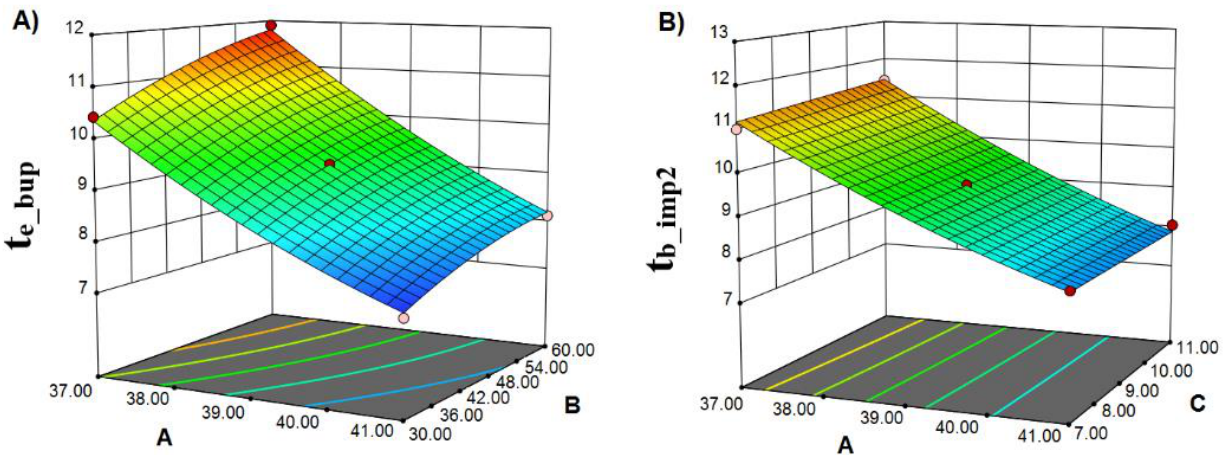
Figure 2. Three-dimensional graphs of ( A ) t e_bup = f (%ACN at the start of the gradient, salt concentration — mM) and ( B ) t b_imp2 = f (%ACN at the start of the gradient, gradient start time — min).